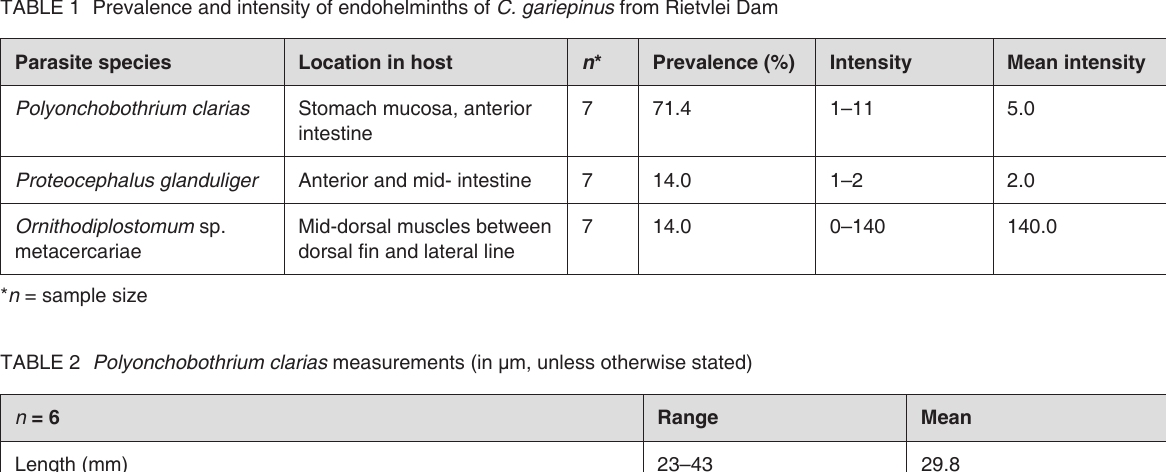
TABLE 2 Polyonchobothrium clarias measurements (in μ m, unless otherwise stated) n = 6 Range